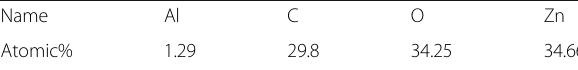
Table 1 The calculated composition of 0.12 M AZO nanospears